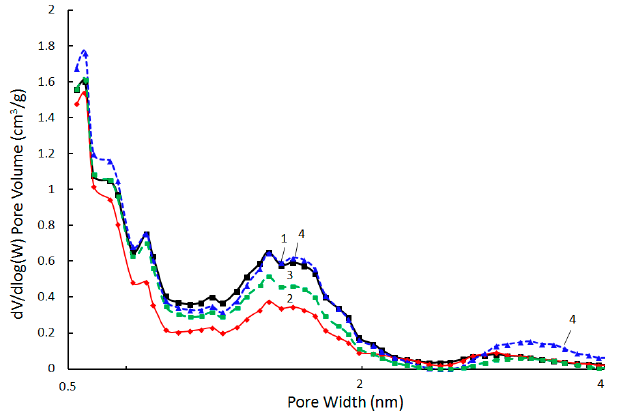
Figure 9. The micropore size distribution curves obtained within NLDFT method using the model for slit-like pores (CM without additives (1) and PCCNC with NGC (2), RGO (3) or GO (4) addi- tives).